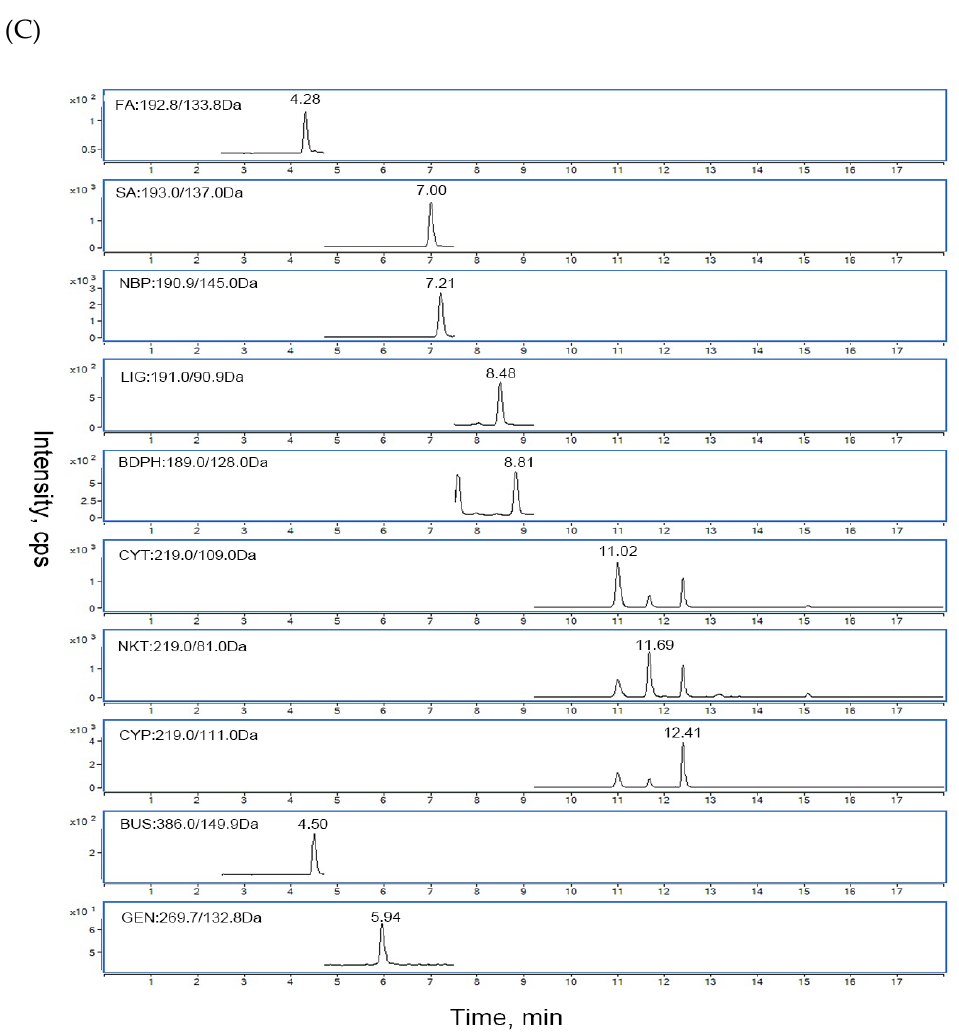
Figure 4. Typical chromatograms of ( A ) blank rat serum; ( B ) blank rat serum spiked with FA, SA, NBP, LIG, BDPH, CYT, NKT and CYP and IS; ( C ) an unknown rat serum sample after oral administration of 6.6 g/kg CRCR extract.